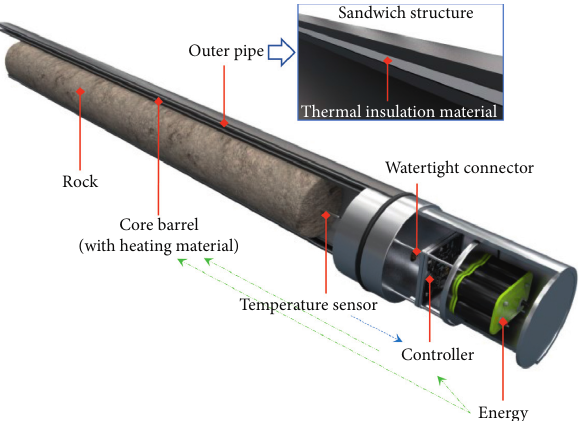
Figure 2: Scheme of thermally insulated coring technology for deep rock.